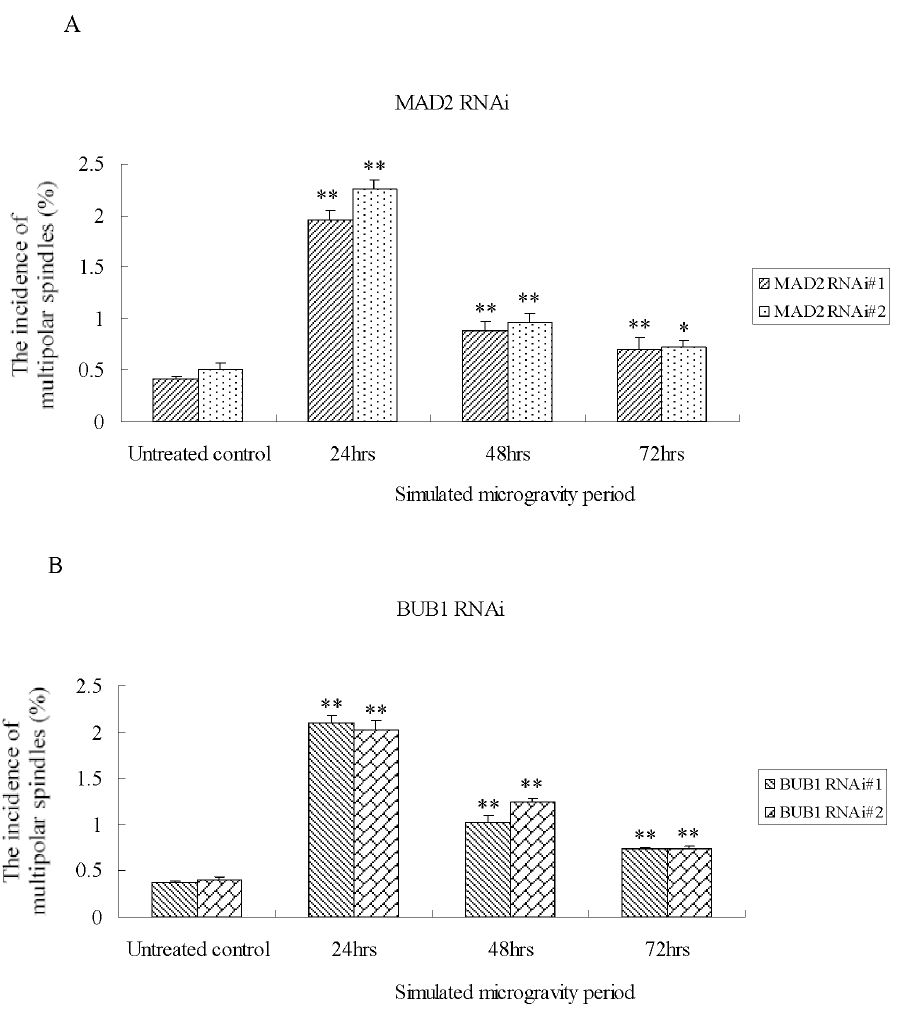
Figure 10. Incidence of multipolar spindles in U-2 OS cells after MAD2 and BUB1 (B knockdown under simulated microgravity. In MAD2 (A) or BUB1(B) knockdown cells, the incidences of multipolar spindles exhibit significant differences as compared with untreated control, but the increase level declines with time length for cell culturing. The data shown represent the mean 6 S.E. (n=3). *0.01 , P , 0.05 and ** P , 0.01 ( x 2 -test as compared to untreated control group).